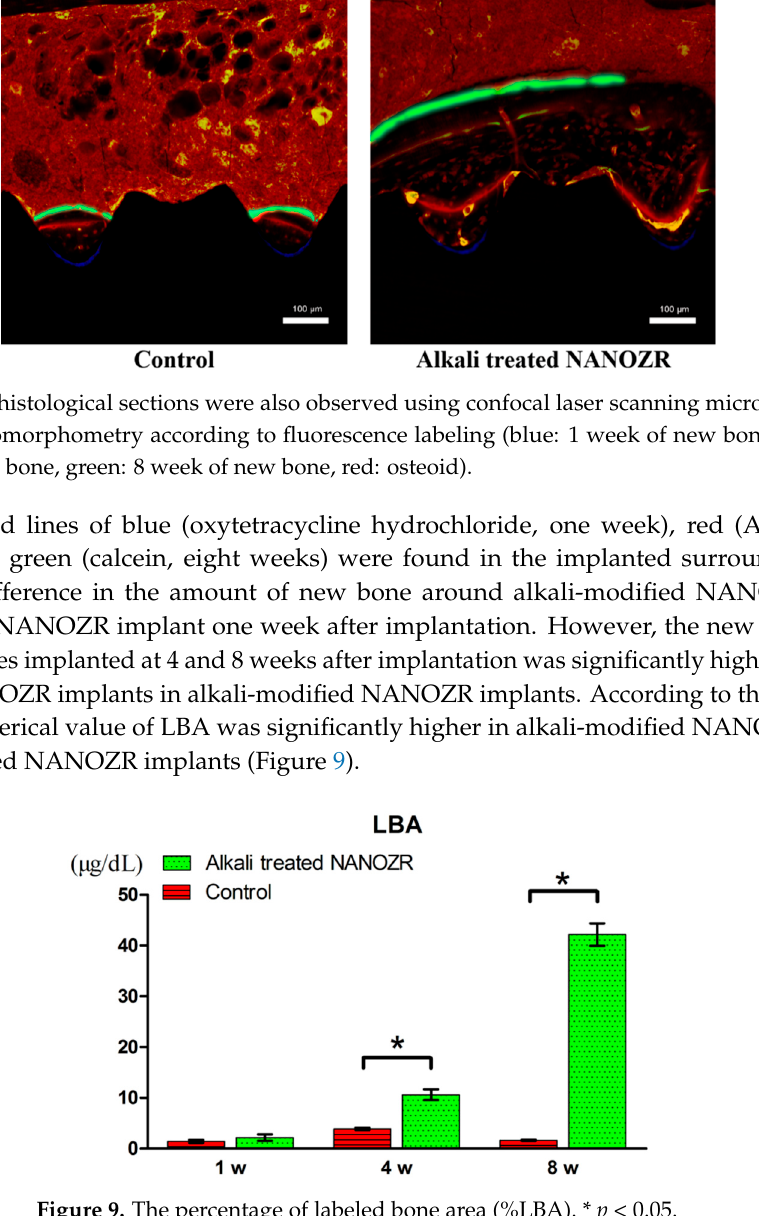
Figure 7. Quantitative histomorphometric analysis within the measured region (bone-implant contact (BIC) and bone area ratio (BA)). * p < 0.05.